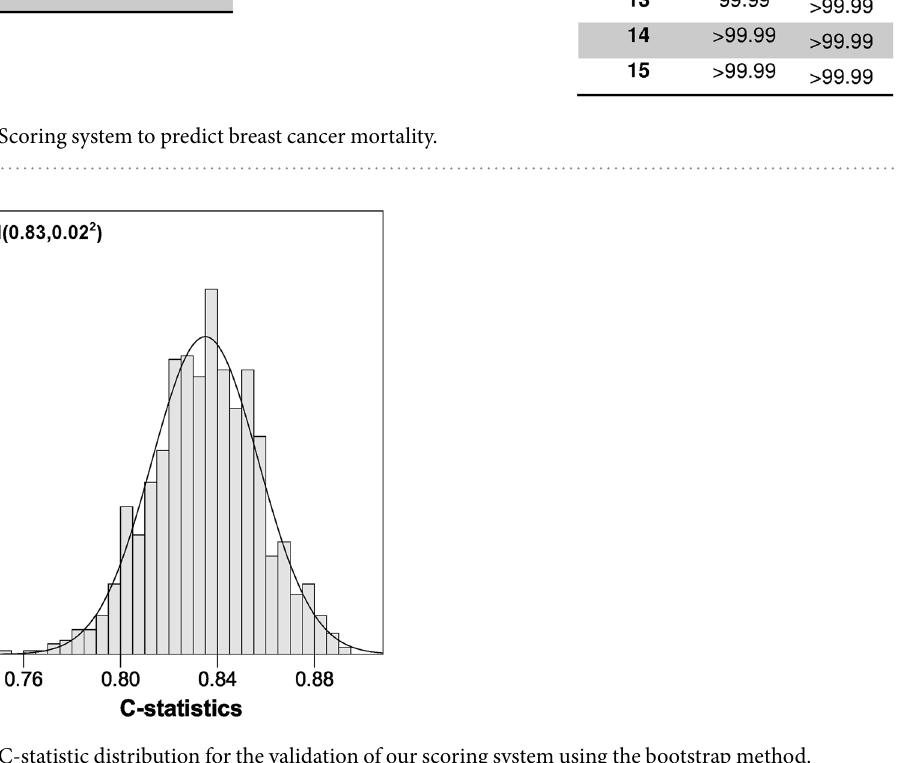
Figure 2. C-statistic distribution for the validation of our scoring system using the bootstrap